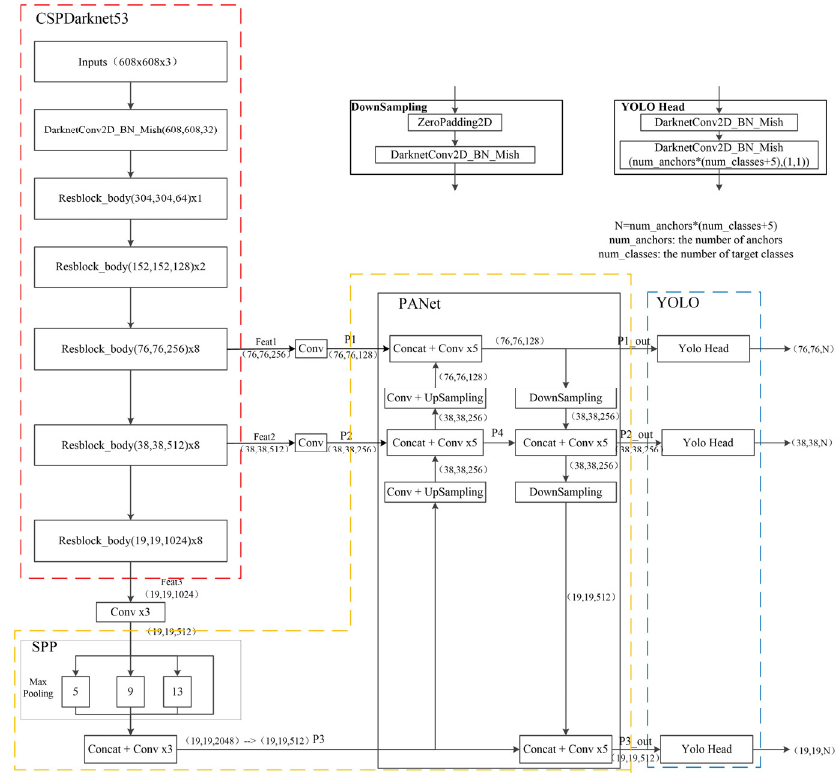
Figure 1. YOLOv4 network structure diagram. * represents multiply.